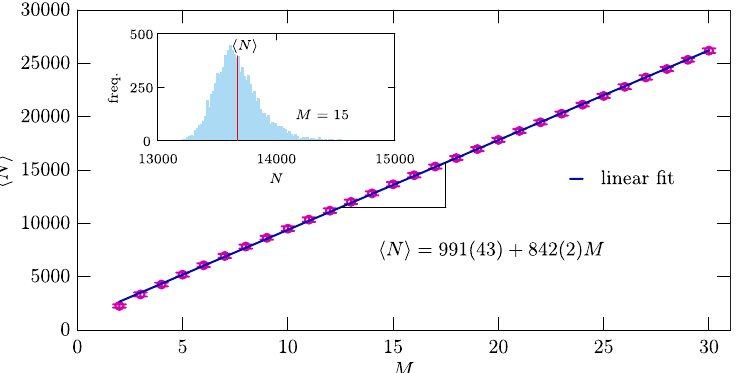
Figure 2. The (cid:31) N (cid:30) average number of individuals in dependence of the local carrying capacity M . The main plot suggests that the average is proportional to M . The actual N number of individuals, however, fluctuates heavily in time. The inset depicts a typical distribution of N values collected from 4 × 10 4 MC steps after 10 8 MC relaxation steps when M = 15 . The calculated average (cid:31) N (cid:30) is marked by a red line in the inset.